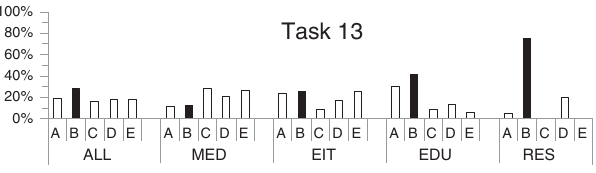
FIG. 7. The students ’ responses to the task referring to the molecular velocity concept. For a detailed description see Fig.